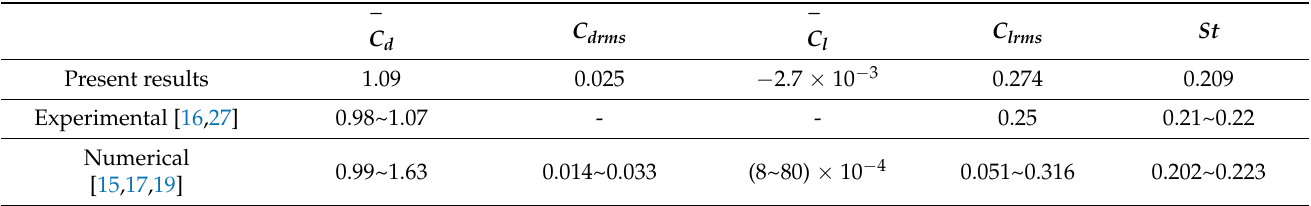
Figure 3. y + distribution of wall surface of bare cylinder. Table 2. Comparison of characteristic parameters at Re = 3900.